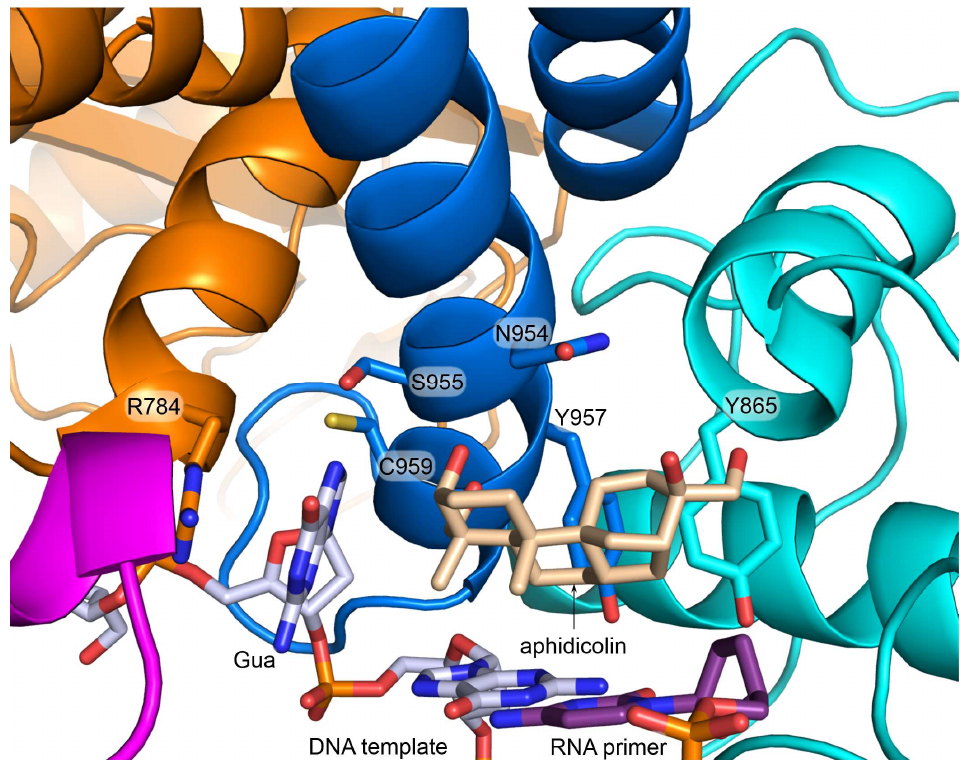
Figure 8. Close-up view of the Polα active site with bound aphidicolin and the DNA:RNA duplex. The color scheme for p180core subdomains is same as in Figure 7. The carbons of aphidicolin are colored wheat. Side chains of the key residues, participating in hydrophobic interactions with aphidicolin and in stabilization of the syn conformation of the templating guanine, are shown as sticks. RNA primer contains a dideoxy-cytidine at the 3′-end. This figure was drawn using the coordinates of the p180core/DNA:RNA/aphidicolin complex (PDB ID 4Q5V).